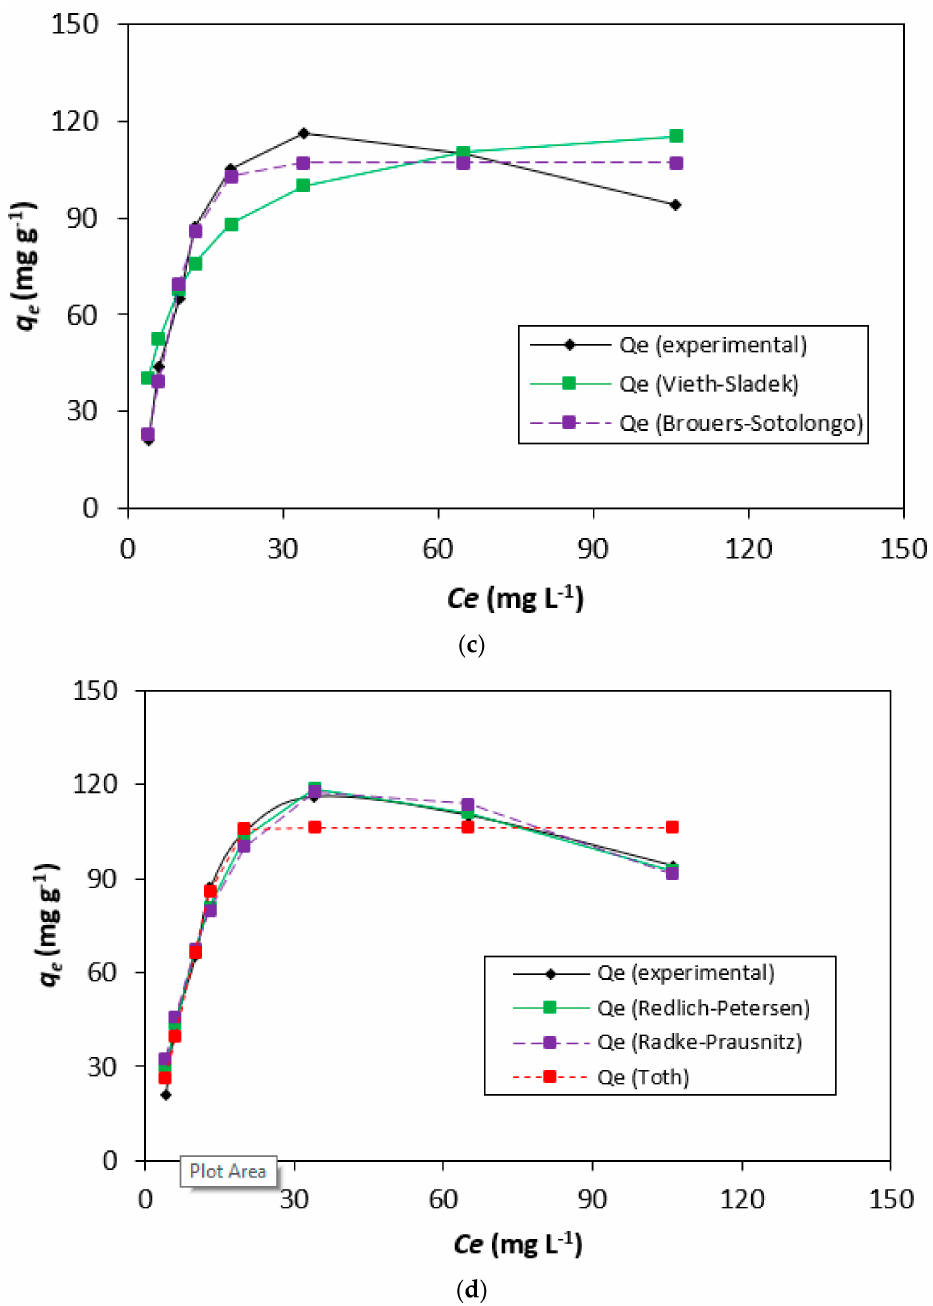
Figure 5. BG-HNT adsorption fit with ( a ) Langmuir and Freundlich; ( b ) Jovanovic and Dubinin- Radushkevich; ( c ) Vieth-Sladek and Brouers-Sotolongo; and ( d ) the Redlich-Peterson, Radke- Prausnitz, and Toth adsorption isotherm.